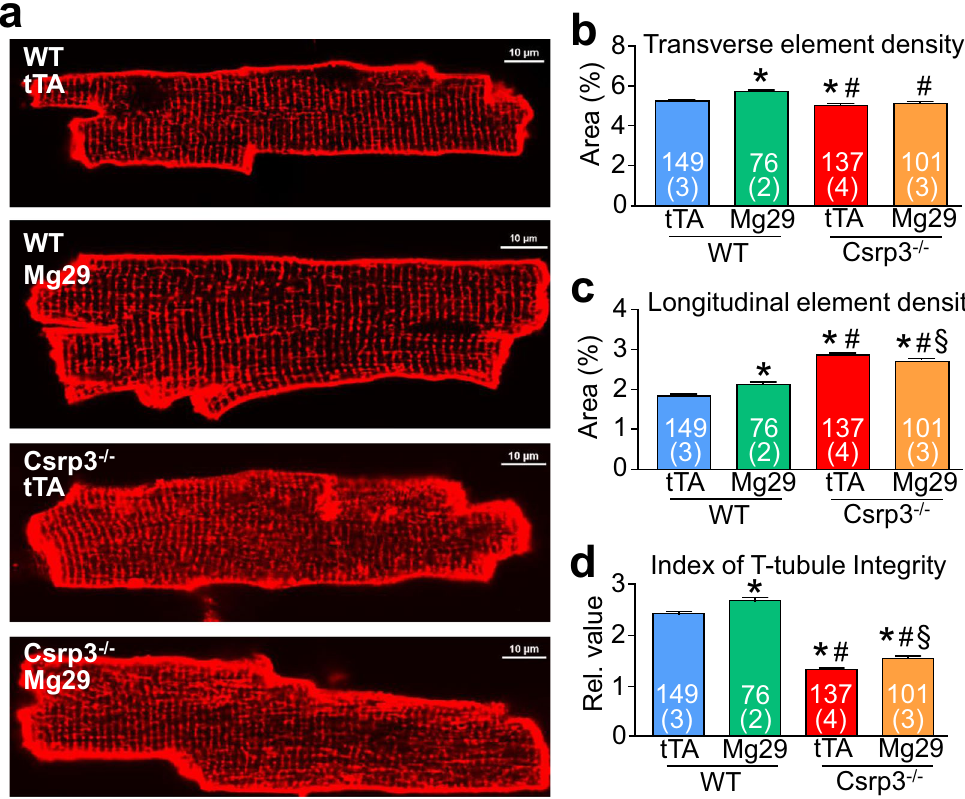
Figure 2. Transgenic expression of Mg29 in hearts of mice lacking MLP protein results in improved t-tubule organization. ( a ) Confocal images of di-8-ANEPPS-loaded cardiac myocytes isolated from wild-type (WT) mice expressing Mg29 or tTA (control), and Csrp3 − / − mice expressing Mg29 or tTA. Densities of cardiac myocyte transverse t-tubule elements ( b ), longitudinal t-tubule elements ( c ), and combined measures of t-tubule integrity ( d ) were generated using AutoTT software. Number of cardiomyocytes (upper number) and mice analyzed (lower number) is shown in the graphs. * P < 0.05 versus tTA (control) group. # P < 0.05 versus Mg29 DTG group. § P < 0.05 versus Csrp3 − / − , tTA